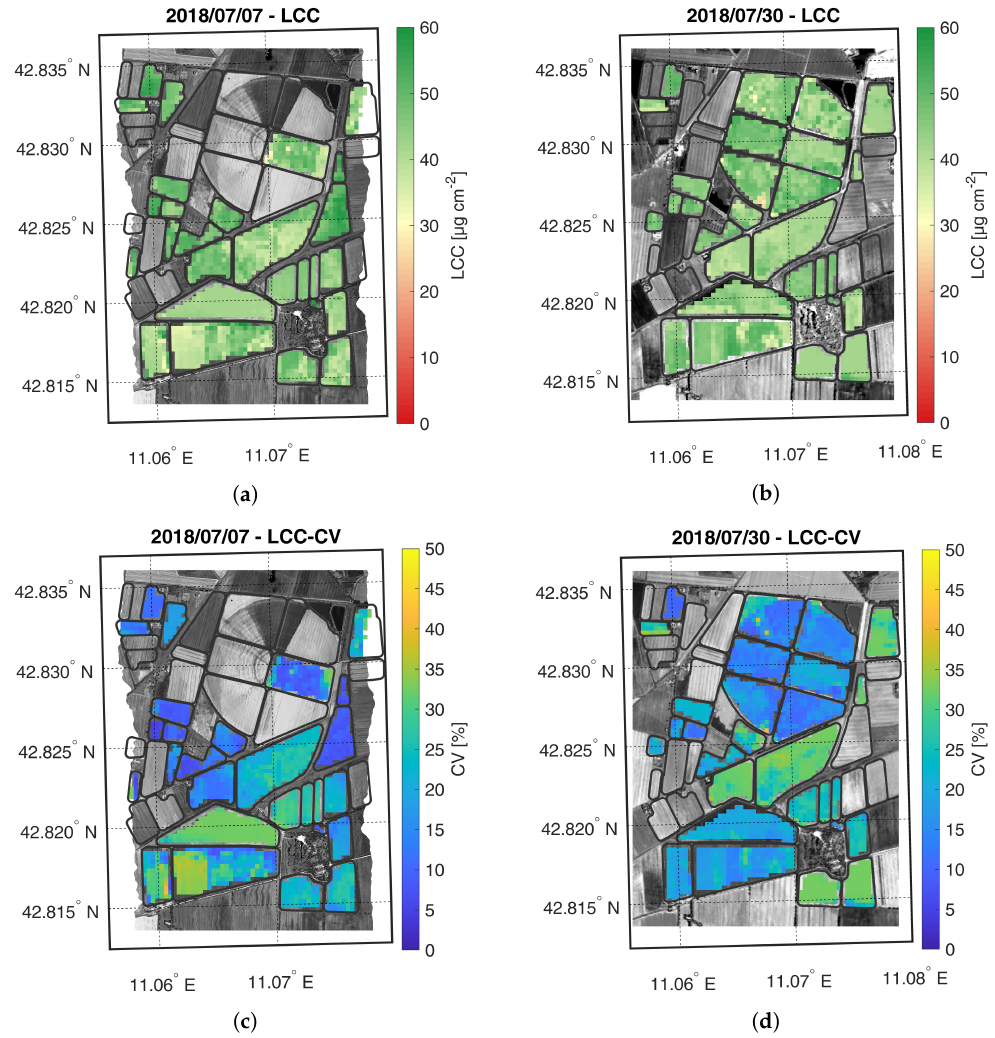
Figure 5. Maps of estimated LCC ( a , b ) and related CV ( c , d ) generated from synthetic CHIME-like images, simulated from the Hyplant-DUAL dataset acquired on 7 and 30 July